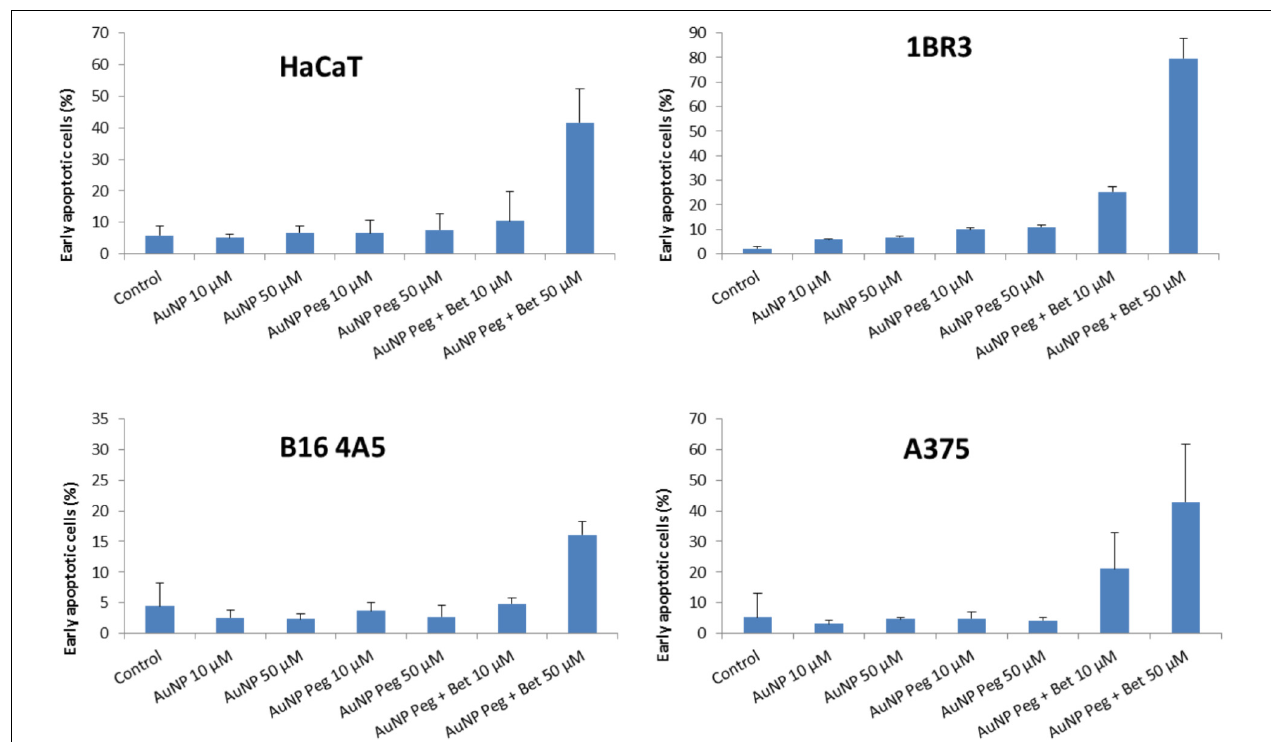
FIGURE 7 | Summarized results of early apoptotic cells percentage of HaCaT, 1BR3, B16 4A5 and A375 cell lines after 72 h of treatment with the tested substances. The results are representative of three independent experiments in triplicate and expressed as mean ±